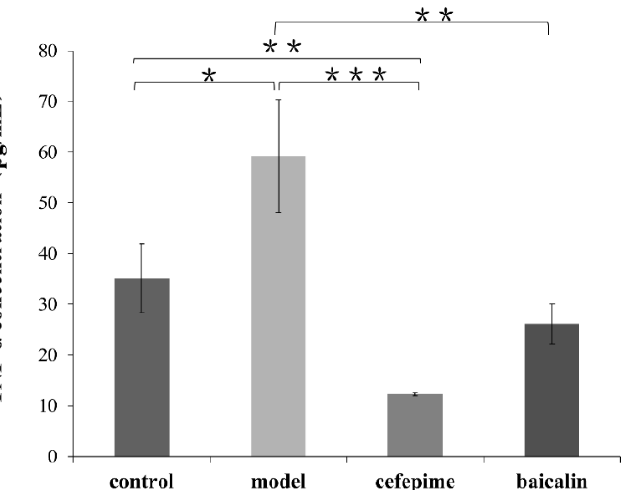
Figure 7. Levels of TNF-α in serum of rats in different groups. Averages of triplicate experiments ± standard errors of the means are shown. The results shown are representative of three independent experiments with similar trends. * significant difference ( p < 0.05); ** very significant differences ( p < 0.01); *** highly significant differences ( p < 0.001).